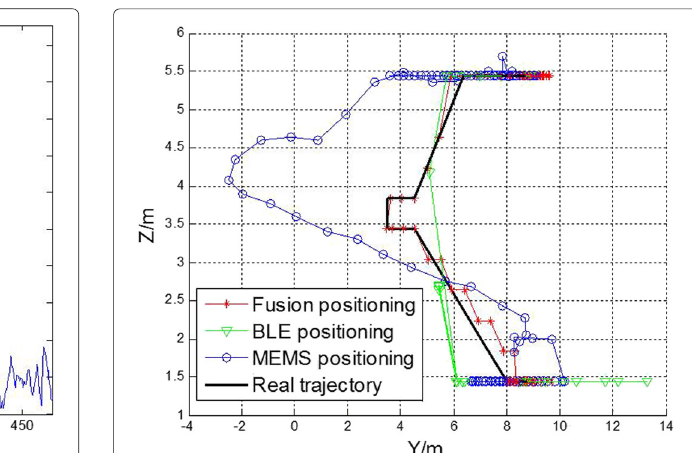
Fig. 27 Projection result in Y - Z plane